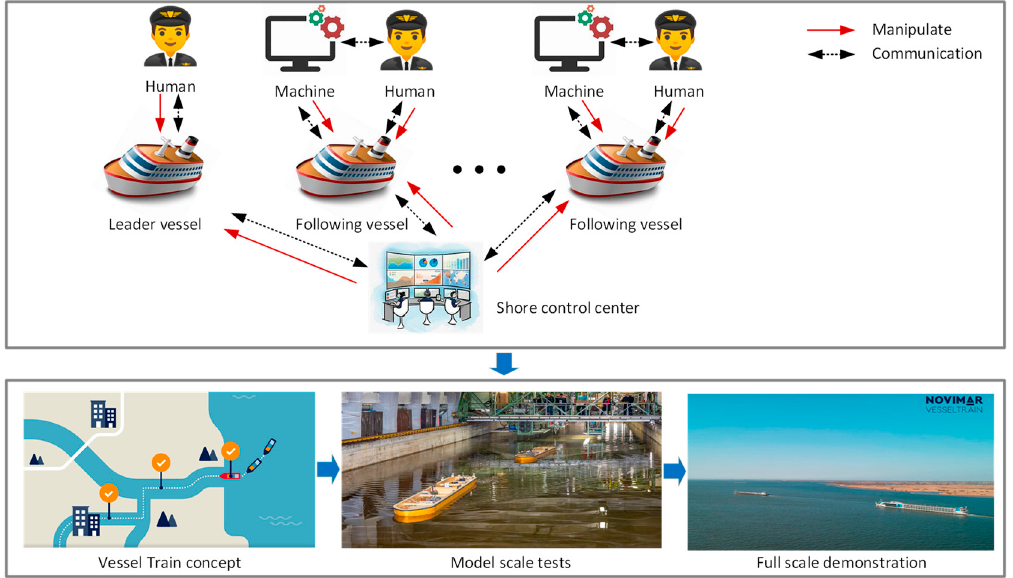
Figure 4. NOVIMAR project development.